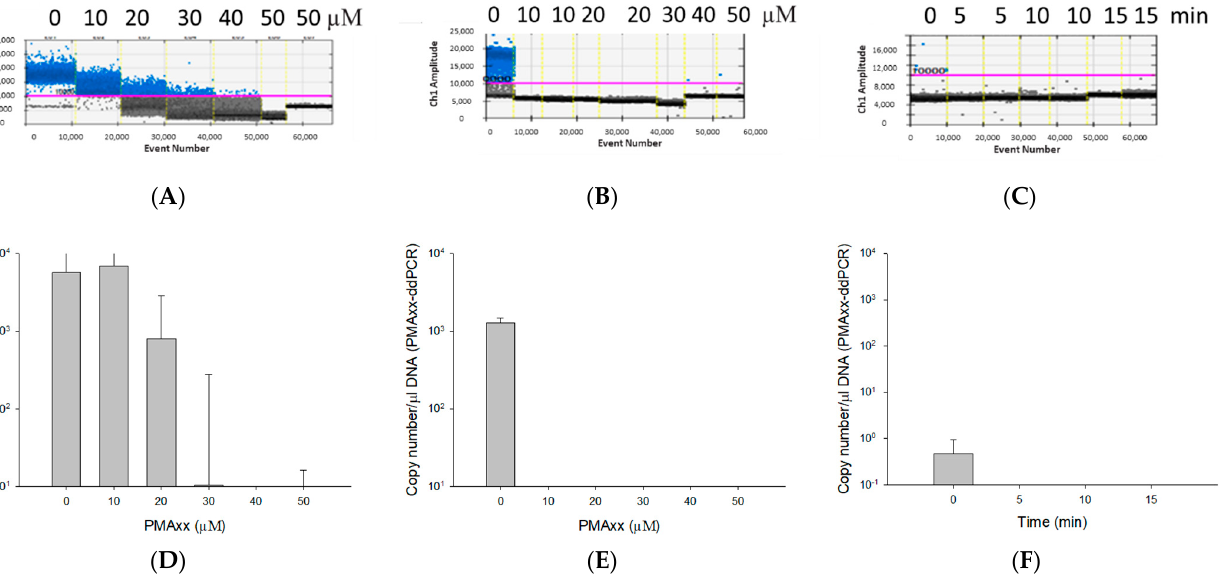
Figure 1. The effect of different concentrations of propidium monoazide (PMAxx) ( A , B , D , E ) and different LED light exposure times ( C , F ). The yellow vertical dotted lines separate results of individual reaction wells ( A – C ). DNA copy number obtained by ddPCR after exposing live ( D ) and dead ( E ) B. cenocepacia J2315 (1.5 × 10 8 CFU/mL) cells to different PMAxx concentrations (0, 10, 20, 30, 40, and 50 μ M PMAxx). DNA copy number obtained by ddPCR after exposing dead B. cenocepacia J2315 (1.5 × 10 8 CFU/mL) to different LED light exposure times (0, 5, 10, and 20 min) ( F ).